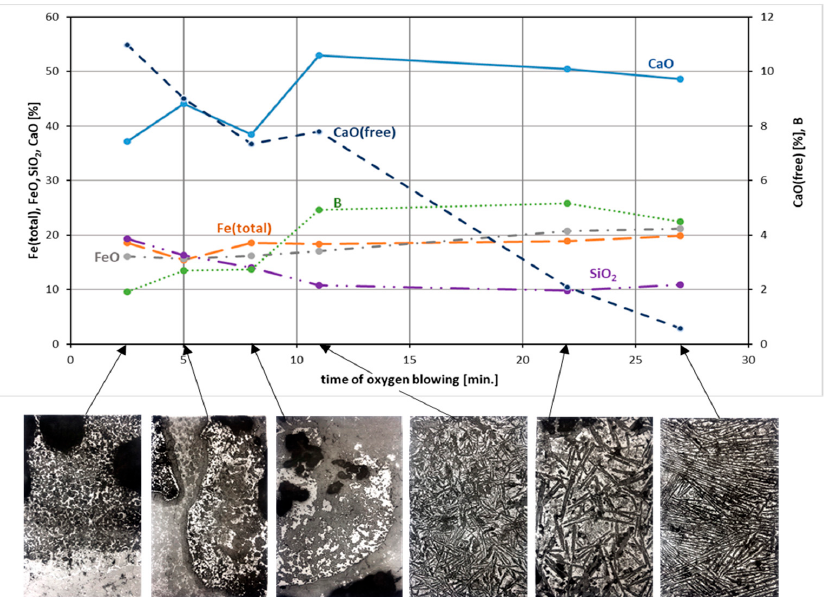
Figure 11. Change in the chemical composition of the slag formed in Melting Process D during oxygen blowing in the oxygen converter and the corresponding change in the slag structure.